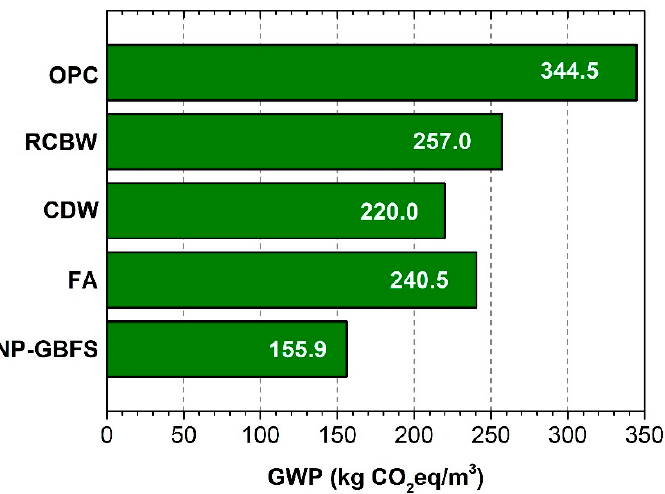
Figure 8. Carbon footprint (GWP: kg · CO 2 · eq/m 3 ) associated with the raw materials of the concrete mixes used in the production of the blocks (alkali-activated blocks vs. OPC block).